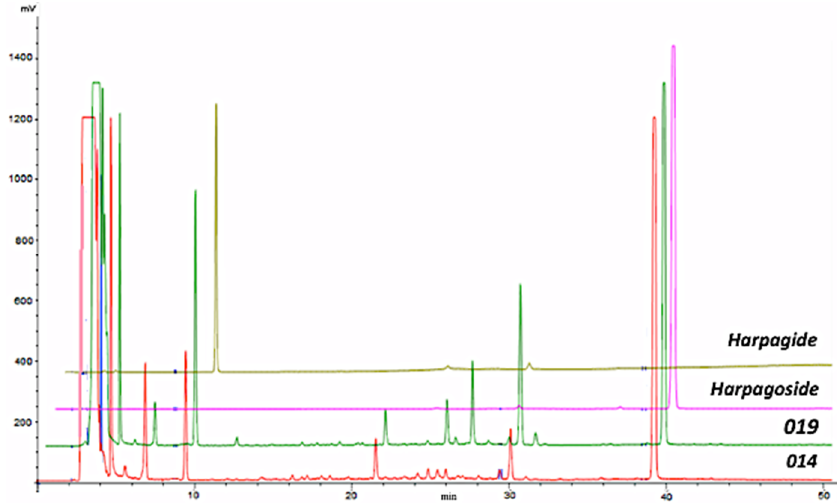
Figure 3. HPLC-ELSD chromatograms of the two spagyric tinctures, 014 and 019: Harpagoside and harpagide.